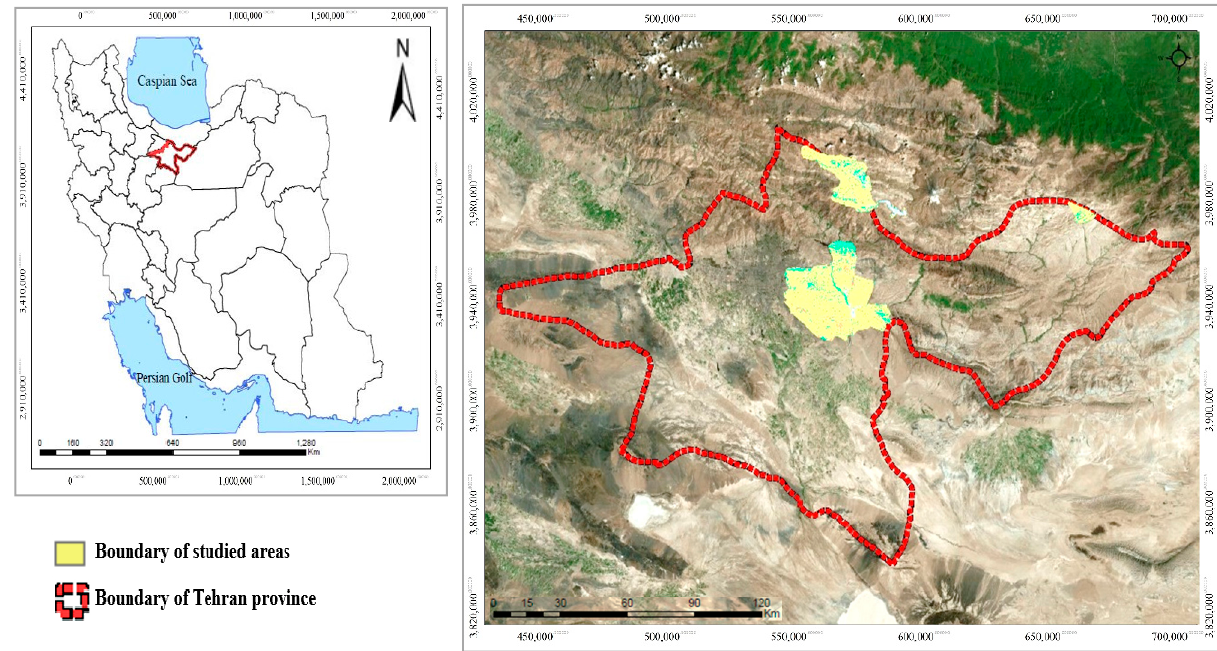
Figure 1. Location of the studied areas; ( a ) Lar, ( b ) Jajrud, and ( c ) TangehVashi. 2.2. Methods 2.2.1. Research Methods Study about the LULC changes is the main prerequisite to quantify landscape frag- mentation level. Therefore, we studied two aspects: (1) the assessment of landscape fea- tures (quantification of landscape metrics such as fragmentation), and (2) analysis of the change of those landscape features. To do this, LULC changes were examined using sat- ellite images during different periods (1989, 1999, 2009, and 2019). Then the statuses of landscape metrics were quantified through the obtained quantitative results. Quantifying the landscape metrics was not possible without examining LULC changes. Hence, the Landsat data archive, which houses historical-spatial information, is essential for study- ing particular land areas for more than 40 years (from 1972 until now). These data have a high application in studying the trend of LULC changes (free and easy access during these years). Landsat images have a high potential to recognize vegetation due to their red (R) and near-infrared (NIR) bands [37,38]. Moreover, considering the first program of socio- economic and cultural development of Iran began in 1989 (after the revolution of the Is- lamic Republic of Iran and the war between Iran and Iraq) and increased the growth of population and urbanization, LULC changes, environmental problems, etc.,